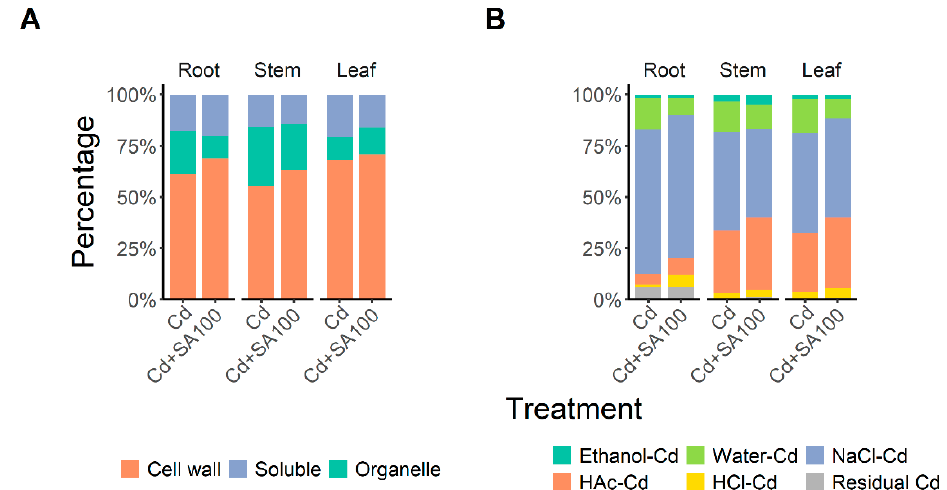
Figure 3. Effects of salicylic acid on the subcellular distribution and chemical form distribution of Cd in the root, stem, and leaf of Tartary buckwheat grown in Cd-contaminated soil. ( A ) Distribution of Cd in the cell wall, organelle, and soluble fractions. ( B ) Chemical form distribution of: ethanol- Cd: inorganic water-soluble Cd extracted using 80% ethanol; Water-Cd: organic water-soluble Cd extracted using deionized water; NaCl-Cd: pectate and protein-integrated Cd extracted using 1 M NaCl; HAc-Cd: insoluble Cd in the form of phosphate complexes extracted using 2% acetic acid water solution; HCl-Cd: insoluble Cd as Cd oxalate extracted using 0.6 M HCl water solution; residual Cd: the final sediment in the extraction procedure. “Cd” denotes the plant group cultivated in the soil with 2.0 mg kg − 1 Cd contamination without salicylic acid treatment; “Cd + SA100” denotes the plant group cultivated in the soil with 2.0 mg kg − 1 Cd contamination with 100 µmol L − 1 salicylic acid treatment.